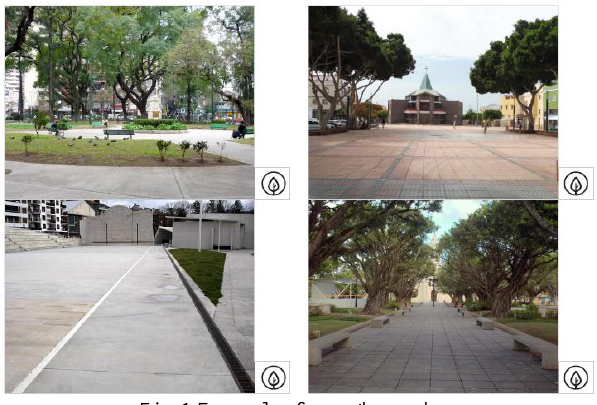
Fig. 1 Example of empathy